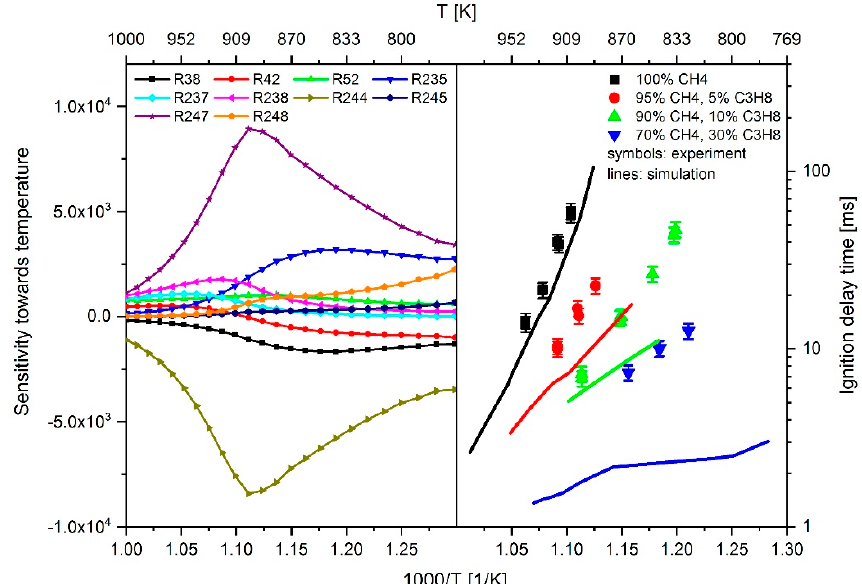
Figure 10. Sensitivity towards temperature simulated with MechA and mix 4 from Table 1 (left); measured IDTs (symbols) and simulated values (lines) using MechA for different methane–propane mixtures (right). The content of methane and propane is given in mol% and corresponds to mix 1 to 4 in Table 1.